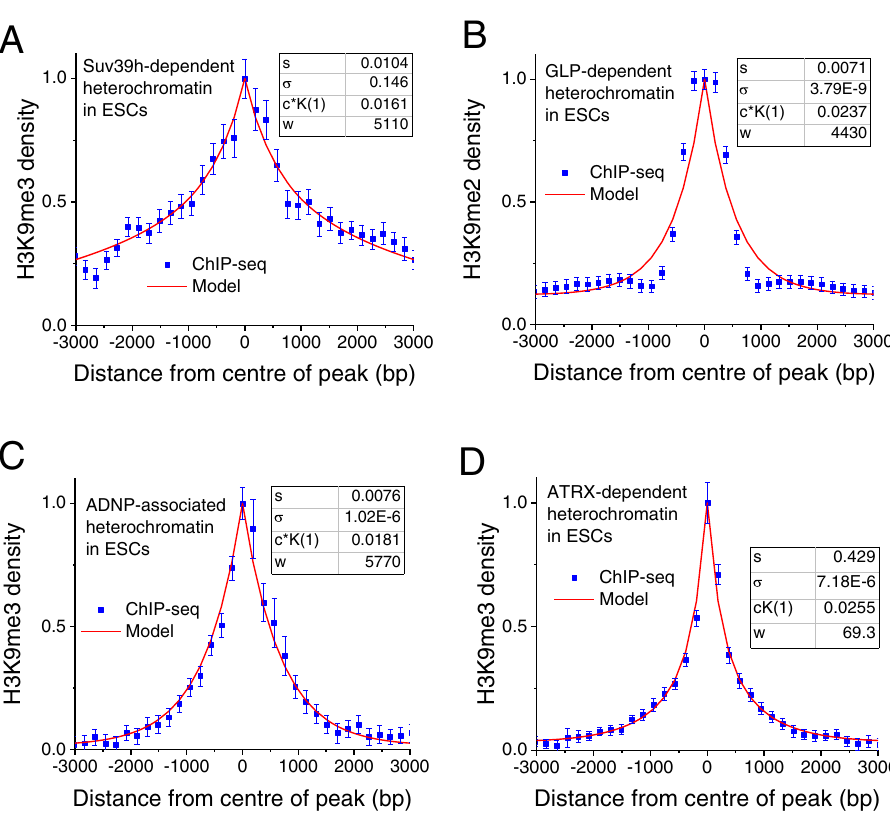
Fig. 3 Shape of averaged H3K9me2/3 pro fi les for different HND types. The experimental H3K9me2/3 ChIP-seq densities were normalised to [0, 1]. Parameters: s is the statistical weight for the nucleosome conversion to heterochromatin state, σ = σ (1, 2) is the weight for interaction between nucleosomes in states 1 (unmethylated) and 2 (methylated). c × K (1) is the product of the local concentration of HP1 proteins in state 1 and the binding constant of HP1 for this state. The mean and standard deviations from two replicates per experiment are shown. A SUV39H-dependent HNDs. B GLP- dependent HNDs. C ADNP-associated HNDs. D ATRX-dependent